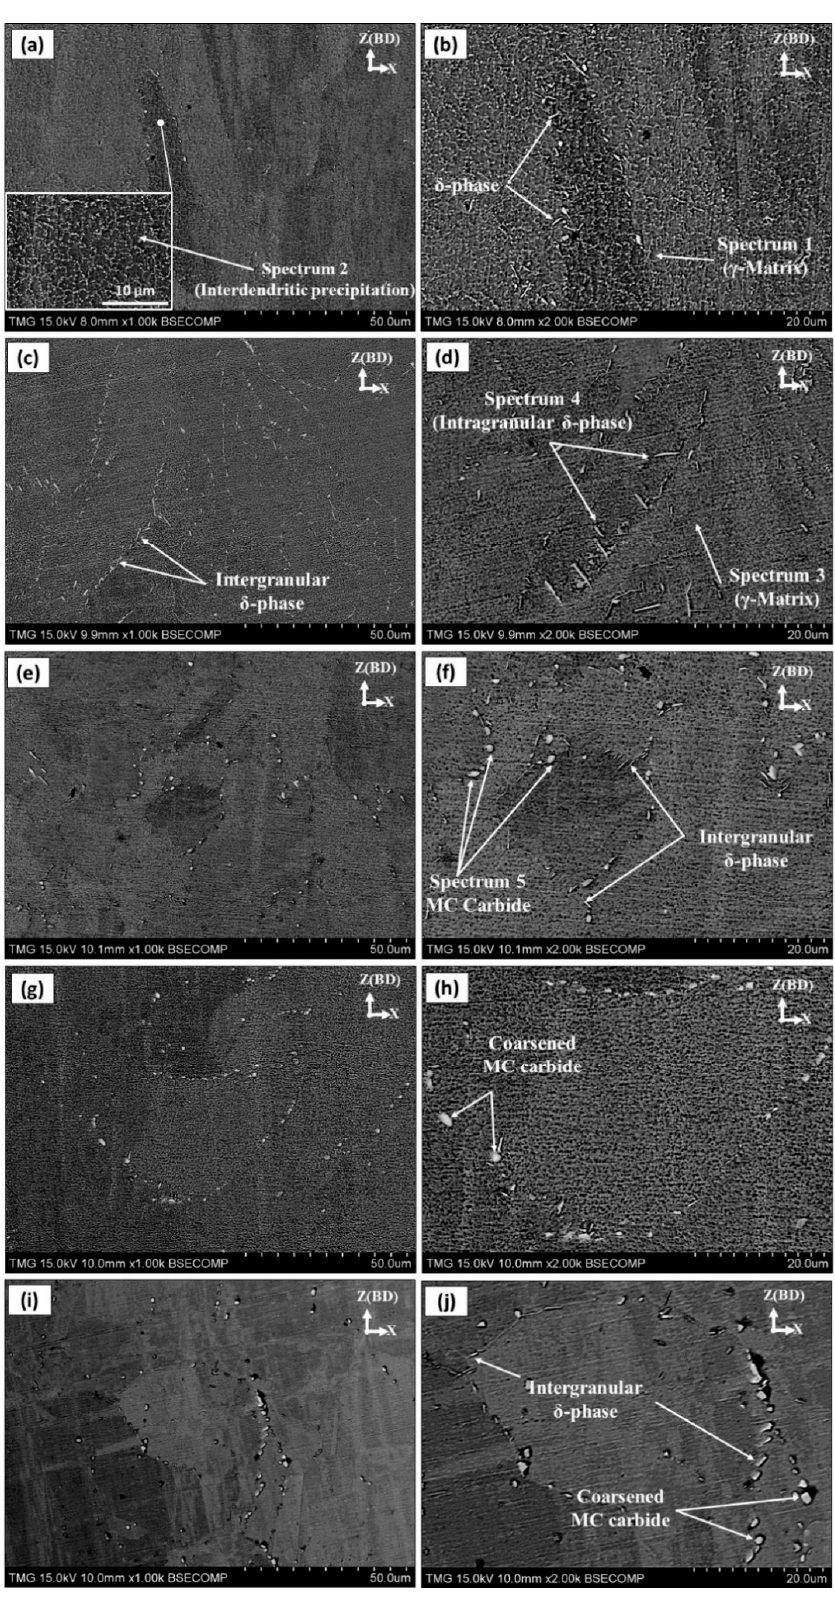
Figure 11. Microstructure of etched LPBF IN718 samples on vertical (xz) plane in heat-treated conditions: ( a,b ) HS1; ( c,d ) HS2; ( e,f ) HS3; ( g,h ) HS4; ( i,j ) HS5 treatments.